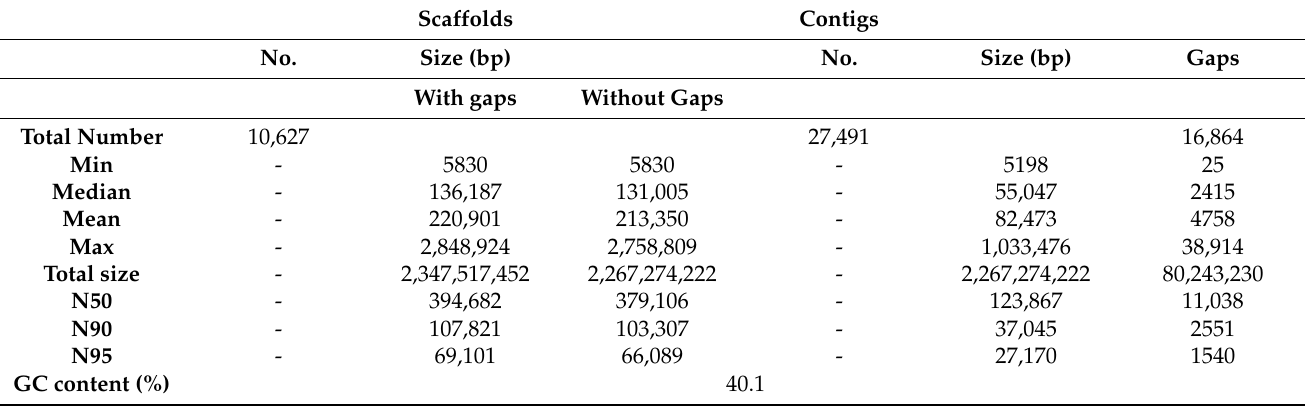
Table 1. Statistics of the final genome assembly of the B. rotunda .